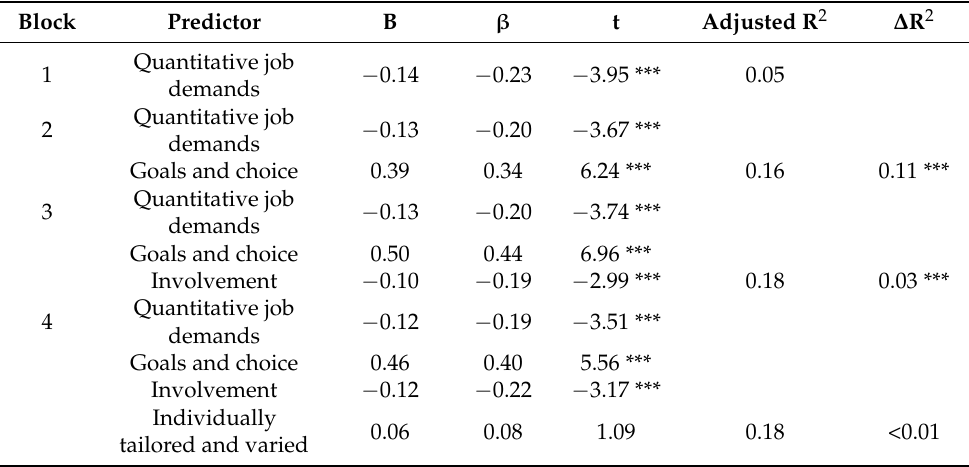
Table 3. Multiple block-wise regression of mastery of work.